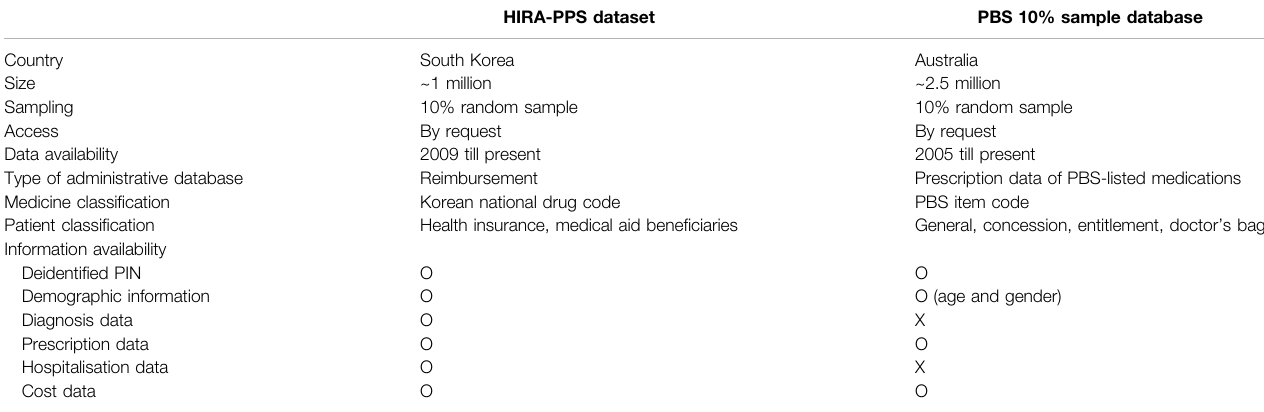
TABLE 1 | Characteristics of HIRA-PPS and PBS 10% sample databases.